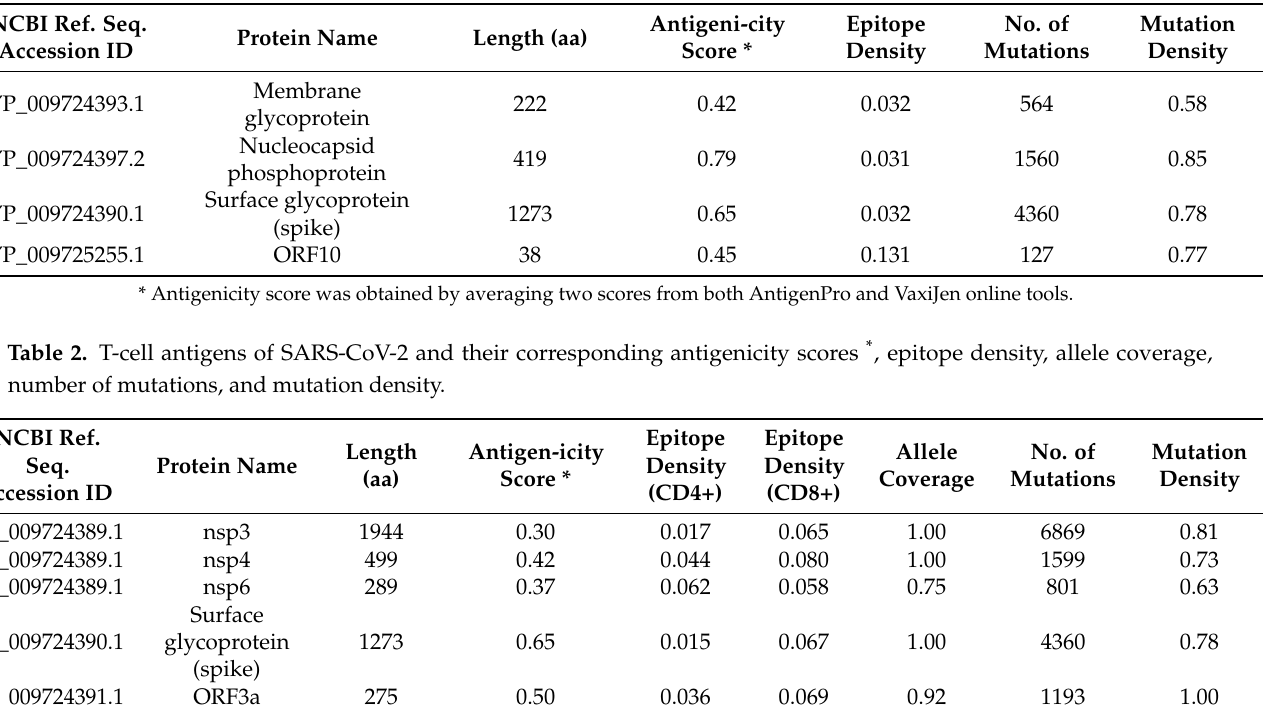
B-cell antigens (Table 1). Three proteins were annotated as viral membrane proteins: membrane glycoprotein (M: YP_009724393.1), nucleocapsid protein (N: YP_009724397.2), and surface glycoprotein (spike: YP_009724390.1). For the T-cell antigens, five proteins (Table 2): nsp3 (YP_009724389.1), nsp4 (YP_009724389.1), nsp6 (YP_009724389.1), spike